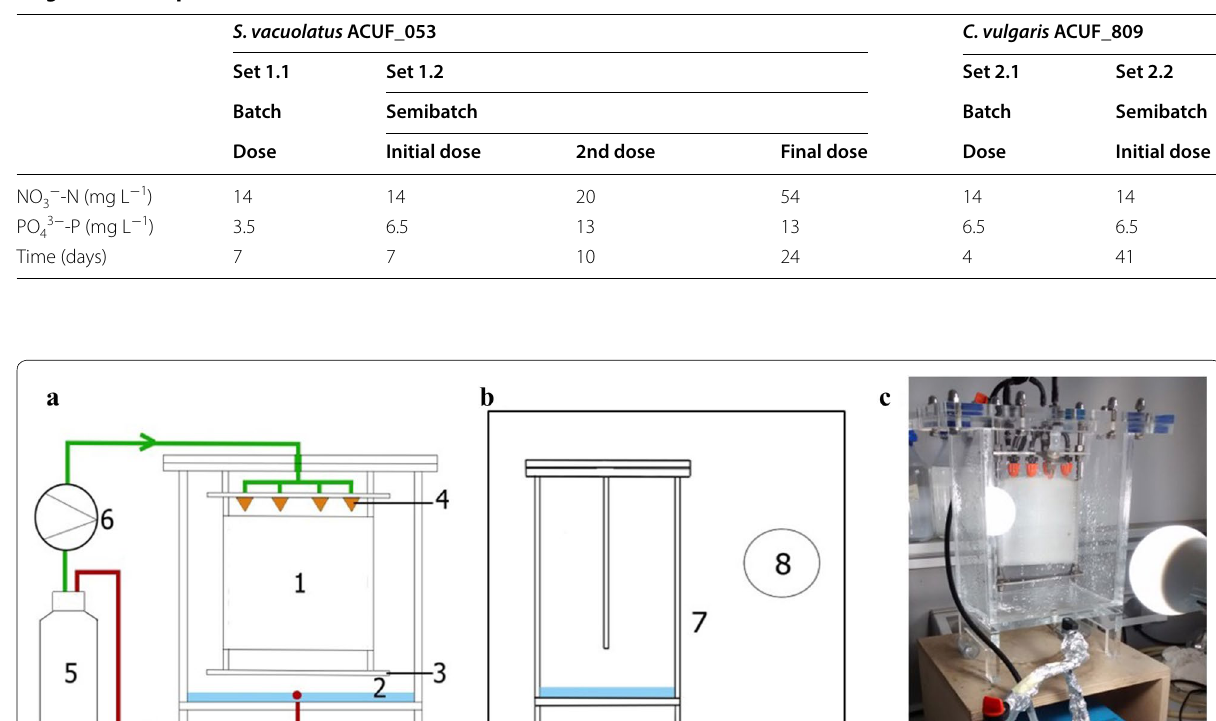
Table 2 Initial nitrogen and phosphorus concentrations used in the experiment of this study on S. vacuolatus and C. vulgaris biofilm performance